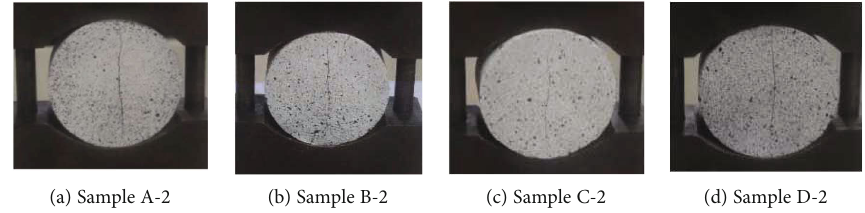
Figure 6: Sandstone sample